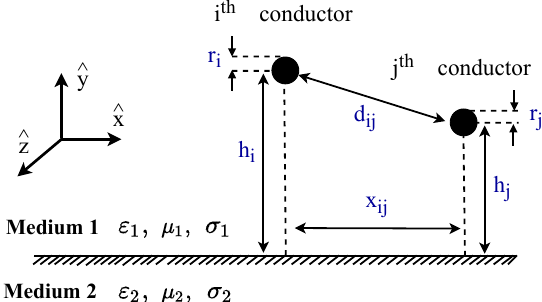
Figure 1. Configuration of the conductors for an overhead